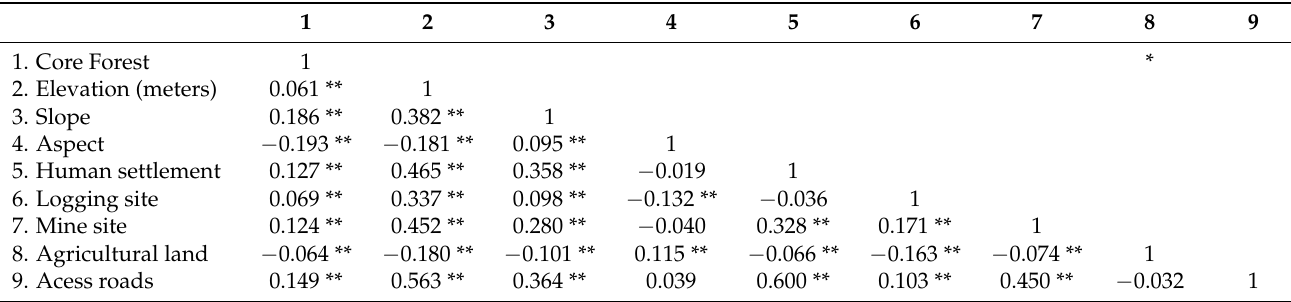
Table A2. Results of Pearson’s correlation analysis.